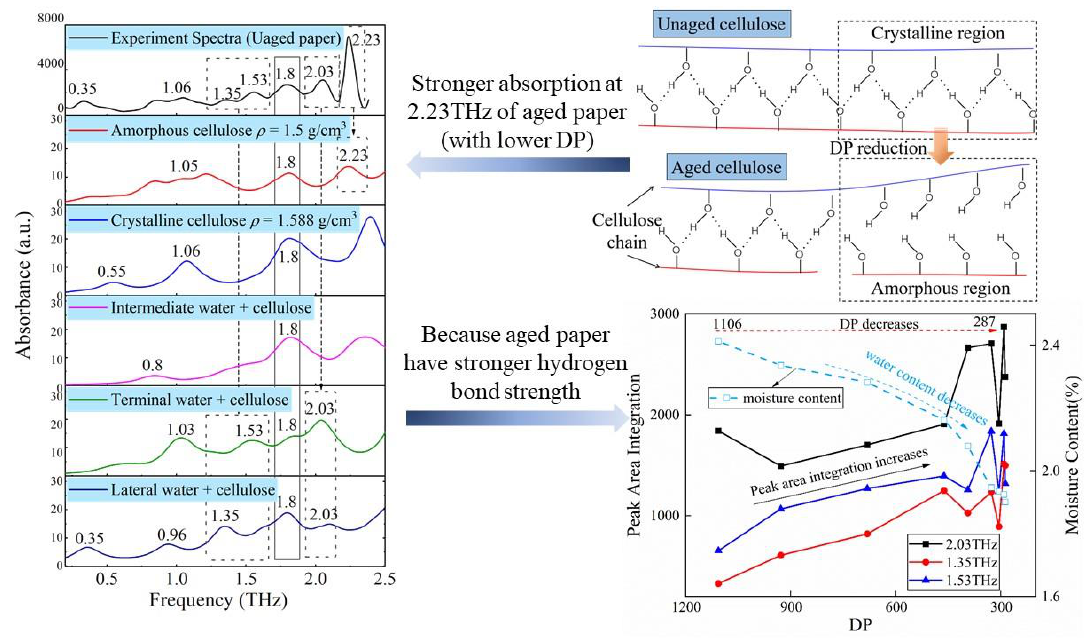
Figure 13. Correlation of DP reduction and terahertz absorption characteristics.